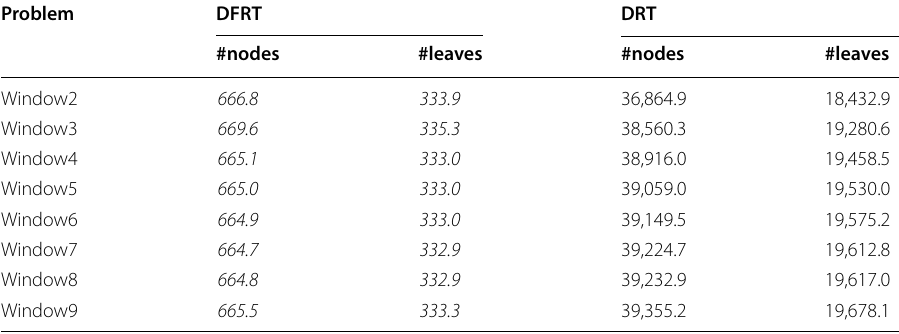
Table 4 Average complexity of the models obtained by DFRT and DRT for the real-world